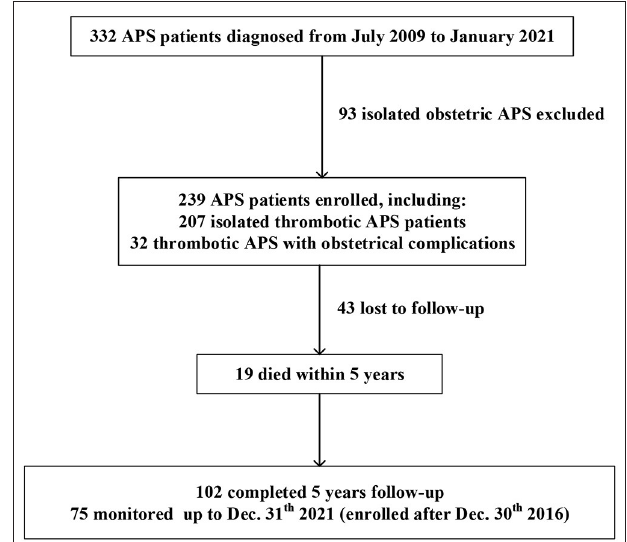
FIGURE 1 | A flow chart of our retrospective study design. Of the 332 APS patients recruited, 239 thrombotic APS patients were enrolled.